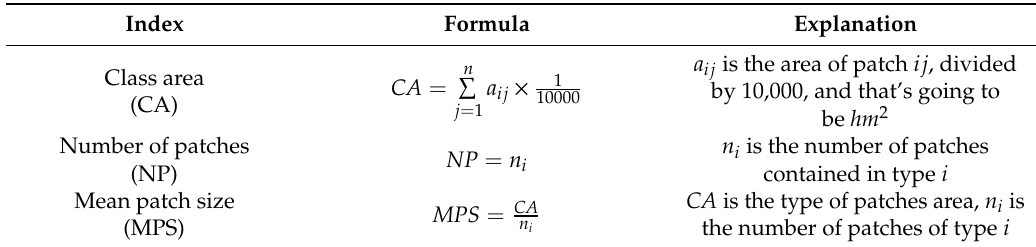
Table 2. Landscape spatial pattern